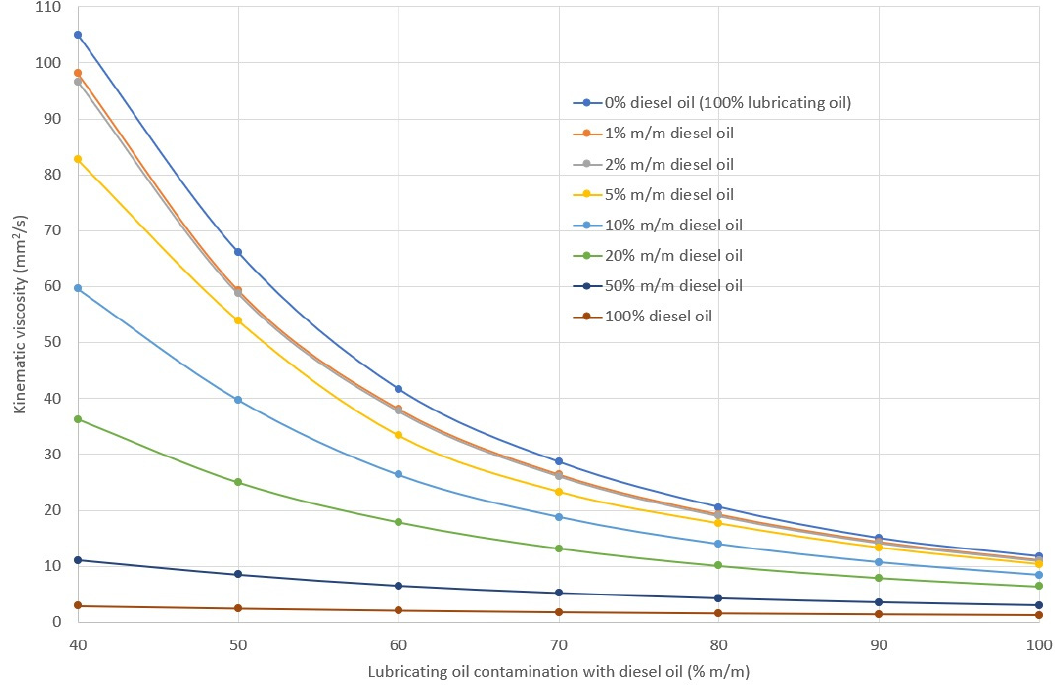
Figure 14. Measured kinematic viscosity values of SAE 30 grade oil in the temperature range of 40–100 °C at different levels of lubricating oil dilution with diesel fuel.